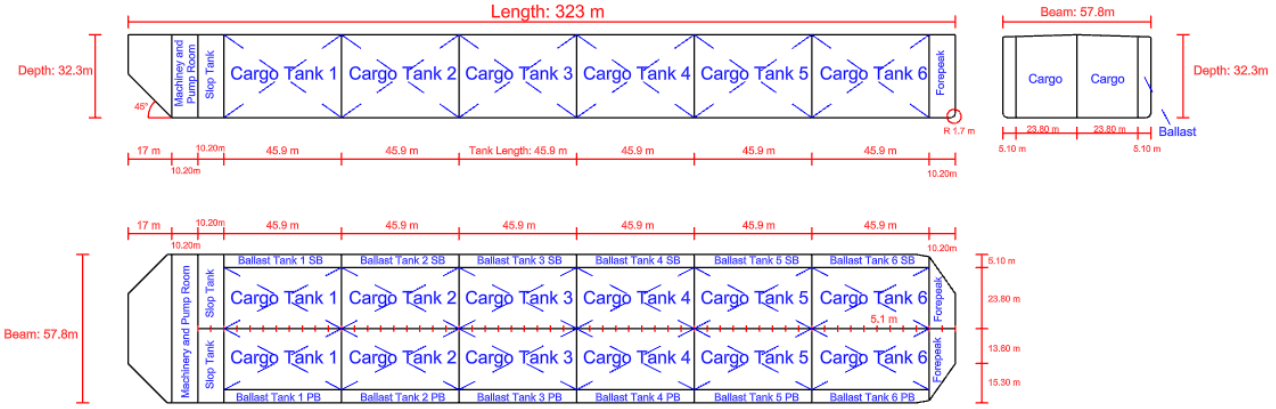
Figure 2. Lines plan of the hull.